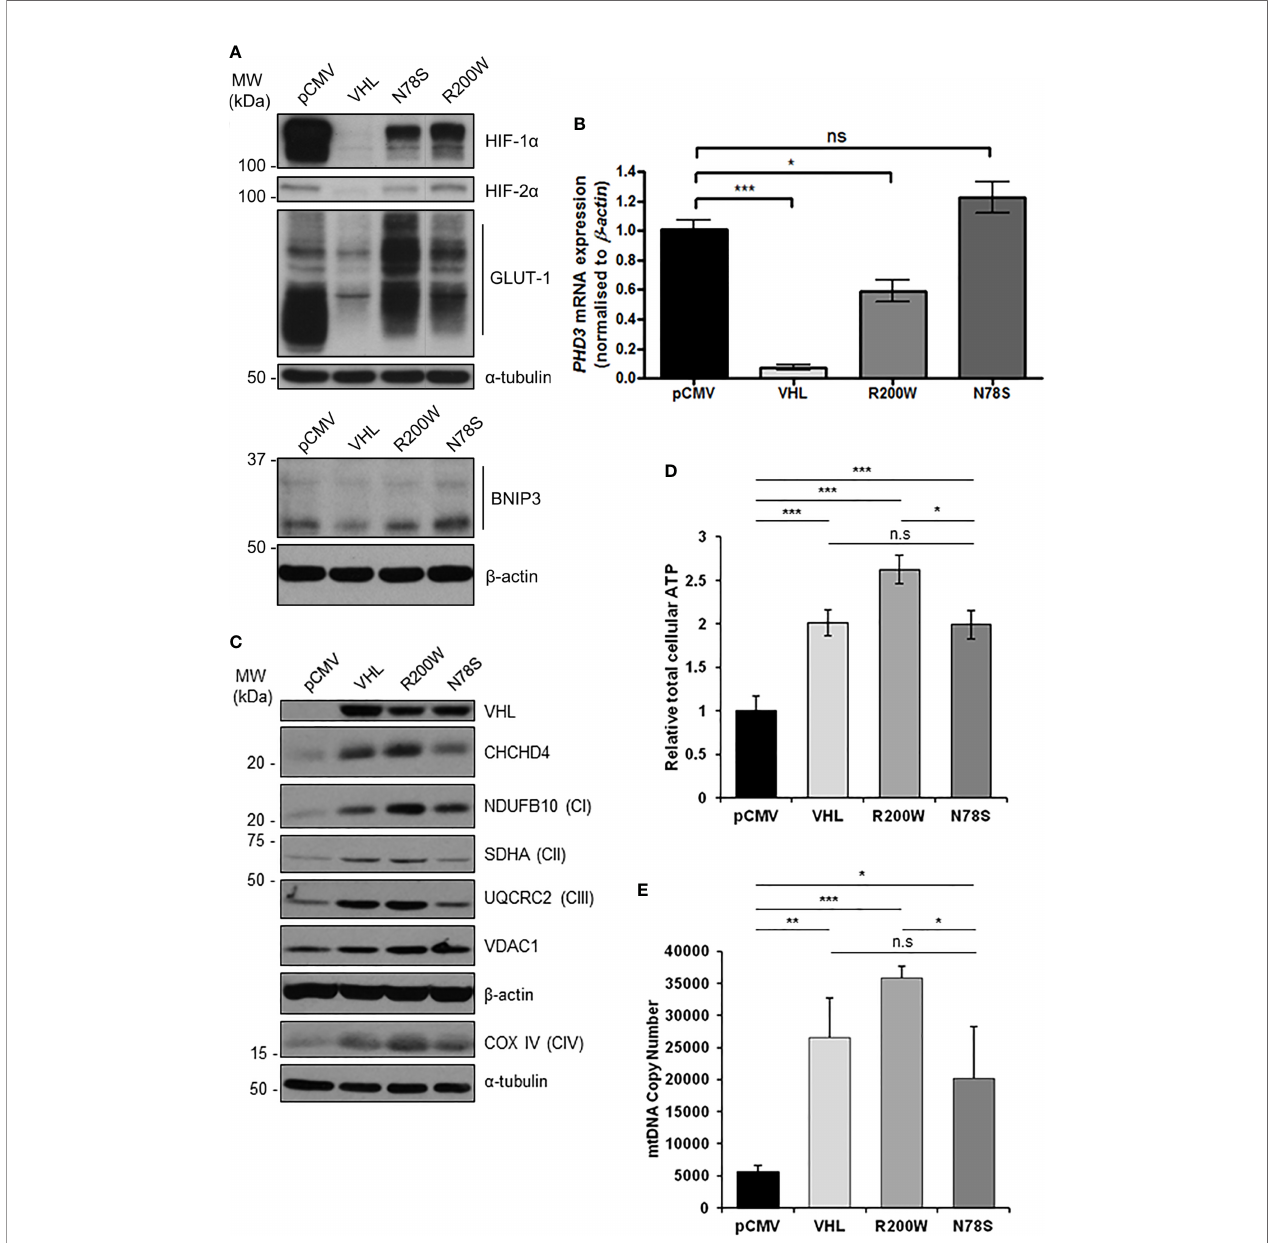
FIGURE 4 | pVHL mutants differentially regulate mitochondrial protein expression, mtDNA copy number and ATP levels. (A) Western blots show HIF-1 a , HIF-2 a , GLUT-1, and BNIP3 protein levels in RCC10 cells expressing empty vector (pCMV), wild type pVHL (VHL), or pVHL mutants (R200W or N78S). a -tubulin and b -actin were used as load controls. (B) Relative expression of PHD3 mRNA in RCC10 cells described in (A) , measured using RT-qPCR. Data were analyzed using the comparative Ct method. Data are presented as mean ± S.E.M. n = 3 (n.s. p > 0.05, *p < 0.05, and ***p < 0.001). (C) Western blots show expression of mitochondrial proteins CHCHD4 and VDAC1, and respiratory chain subunits NDUFB10 (CI), SDHA (CII), UQCRC2 (CIII), COX IV (CIV) in RCC10 cells described in (A) . pVHL expression was assessed as a control for re-expression, and b -actin and a -tubulin were used as load controls. (D) Graph shows total cellular ATP content in RCC10 cells expressing wild type pVHL (VHL) or pVHL mutants (R200W or N78S), normalized to cell number (n = 4). (E) Graph shows mtDNA copy number in RCC10 cells expressing pVHL variants, calculated using the ratio of expression of mitochondrial ND1 gene to the single copy nuclear gene, b 2M to by RT-qPCR. Data in (D, E) are presented as mean ± S.D. n = 6 (n.s. p > 0.05, *p < 0.05, **p < 0.01, and ***p <